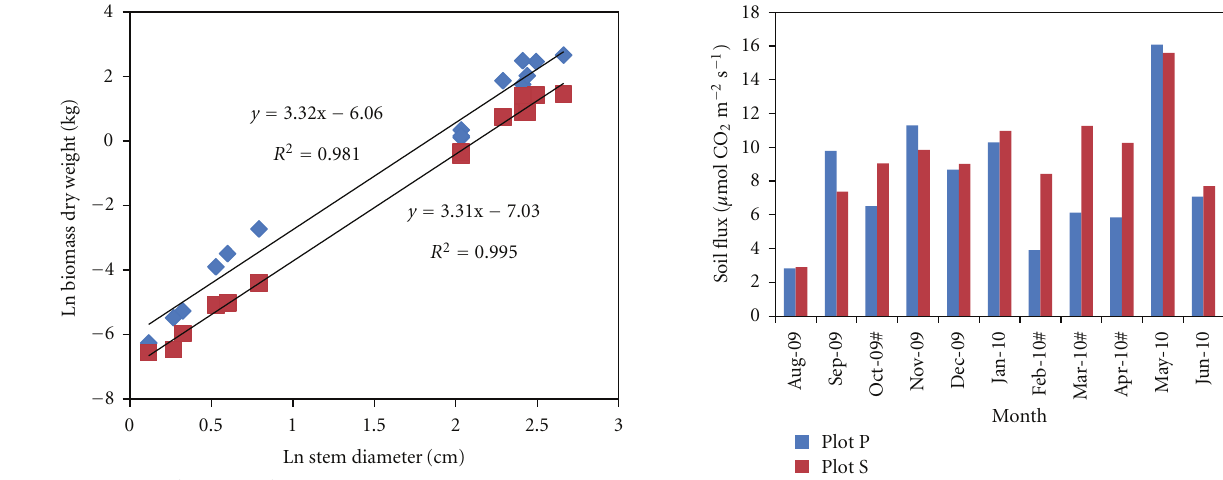
Figure 2: Mean soil flux at plot P and plot S. Months with a # sign indicates that there is a significant di ff erence by t -test ( P > 0 .